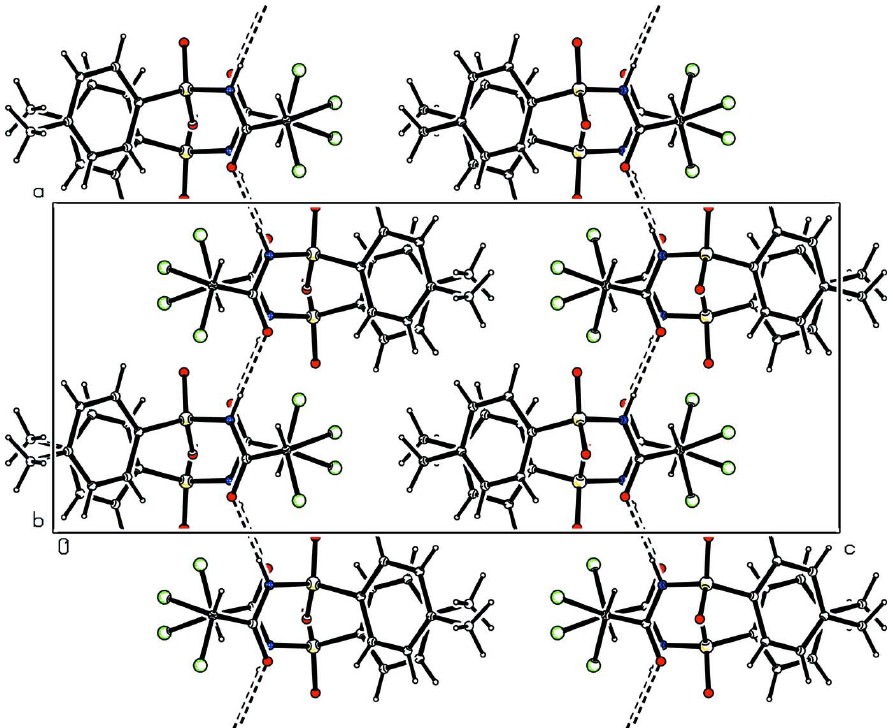
Figure 2 Molecular packing of (I) with hydrogen bonding shown as dashed